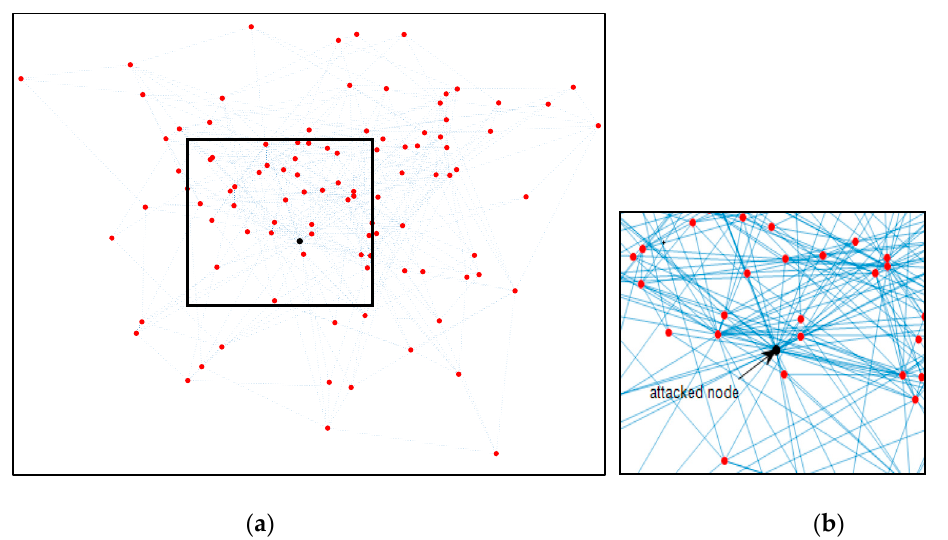
Figure 3. The topology of the cluster head nodes: ( a ) the complete cluster head nodes topology and ( b ) the partially enlarged view of the attacked node.